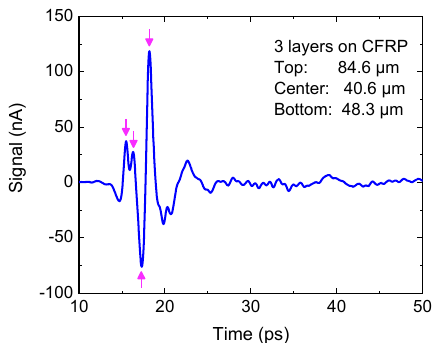
Figure 10. A THz pulse trace reflected from a three-layer coating on a carbon-fiber-reinforced plastic substrate. The echoes from the four interfaces are marked with arrows. Thicknesses of the individual layers are indicated. Courtesy of TOPTICA Photonics AG.